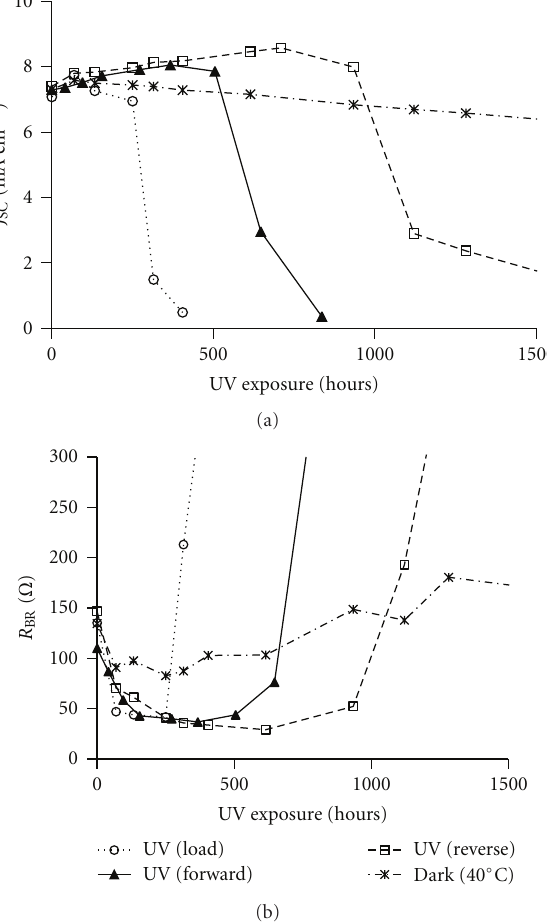
Figure 5: Change in J SC (a) and change in R BR (b) over the UV- exposure period, showing the collapse in photocurrent at the point of cell failure coinciding with a large increase in R BR . The order of cell failure is the same as in Figure